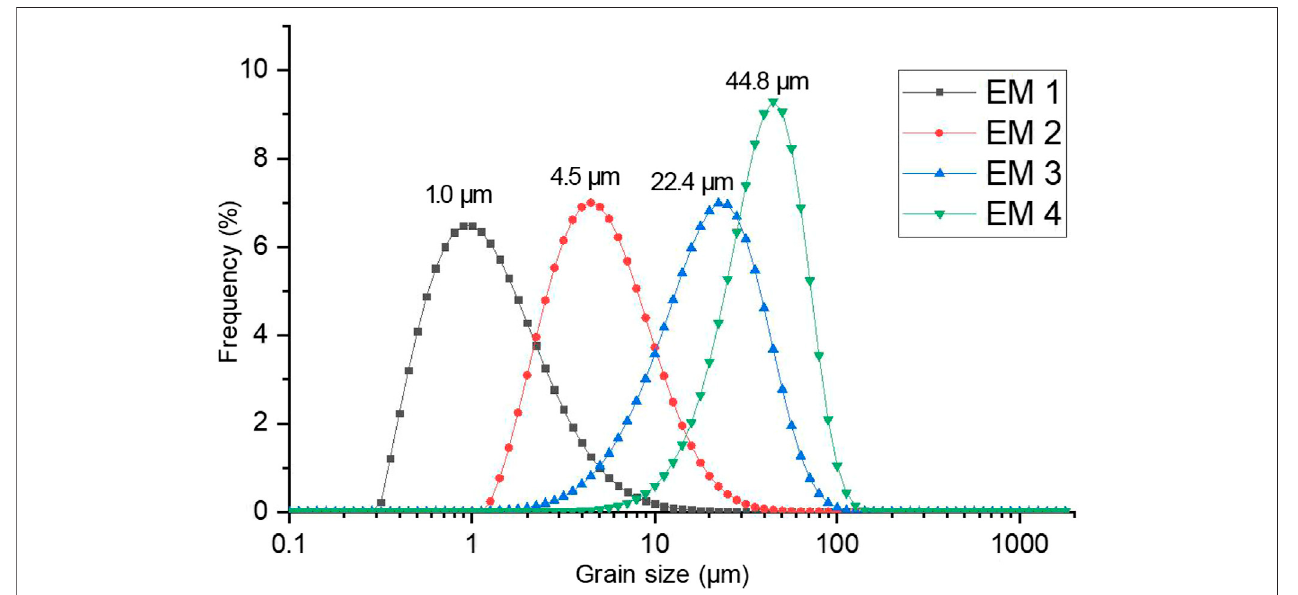
FIGURE 4 | End-member analysis results of the grain size of XG pro fi